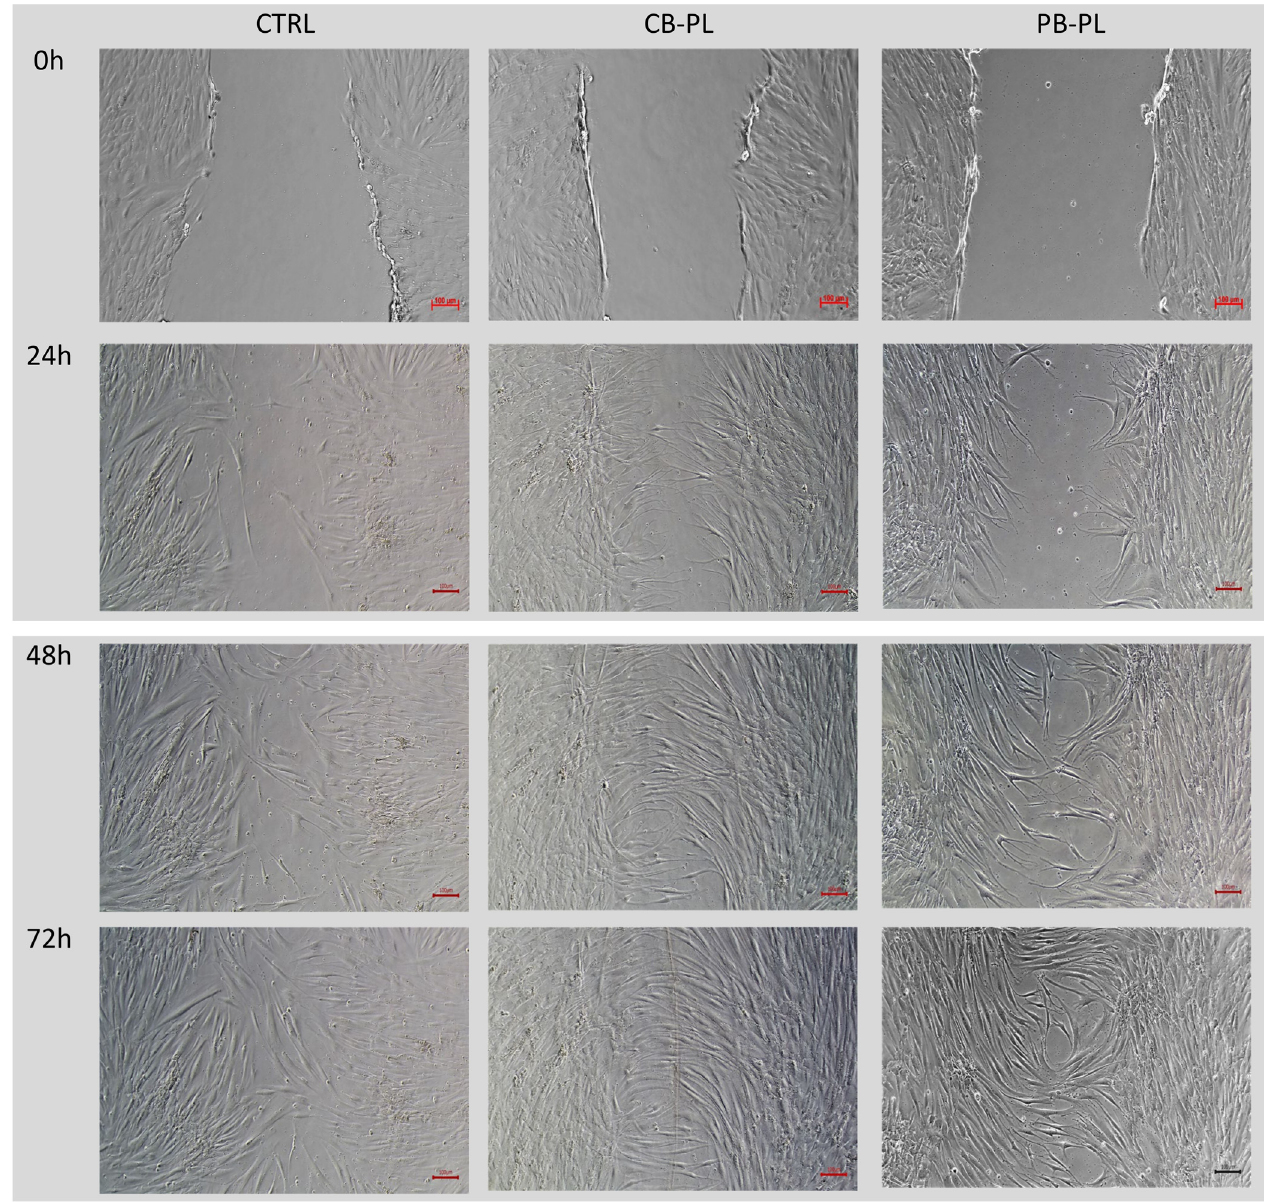
Figure 2. Wound-healing percentage of CTRL, 1.25% CB-PL and 0.3125% PB-PL towards the migra- tion of HOMF. The wound closure was assessed after 24, 48 and 72 h of exposure to culture medium. All data were representative of three independent tests with n = 3 by groups and means ± SEM. * p < 0.05 denoted the statistical signi fi cance of 1.25% CB-PL and 0.3125% PB-PL when compared to CTRL. Figure 3. Phase contrast micrographs of scratch test showed the e ff ect of CTRL, 1.25% CB-PL and 0.3125% PB-PL towards the migration of HOMF under 100× magni fi cation. The wound closure was assessed after 24, 48 and 72 h of exposure to culture medium. The wounds were closed faster in 1.25% CB-PL and 0.3125% PB-PL compared to the CTRL.